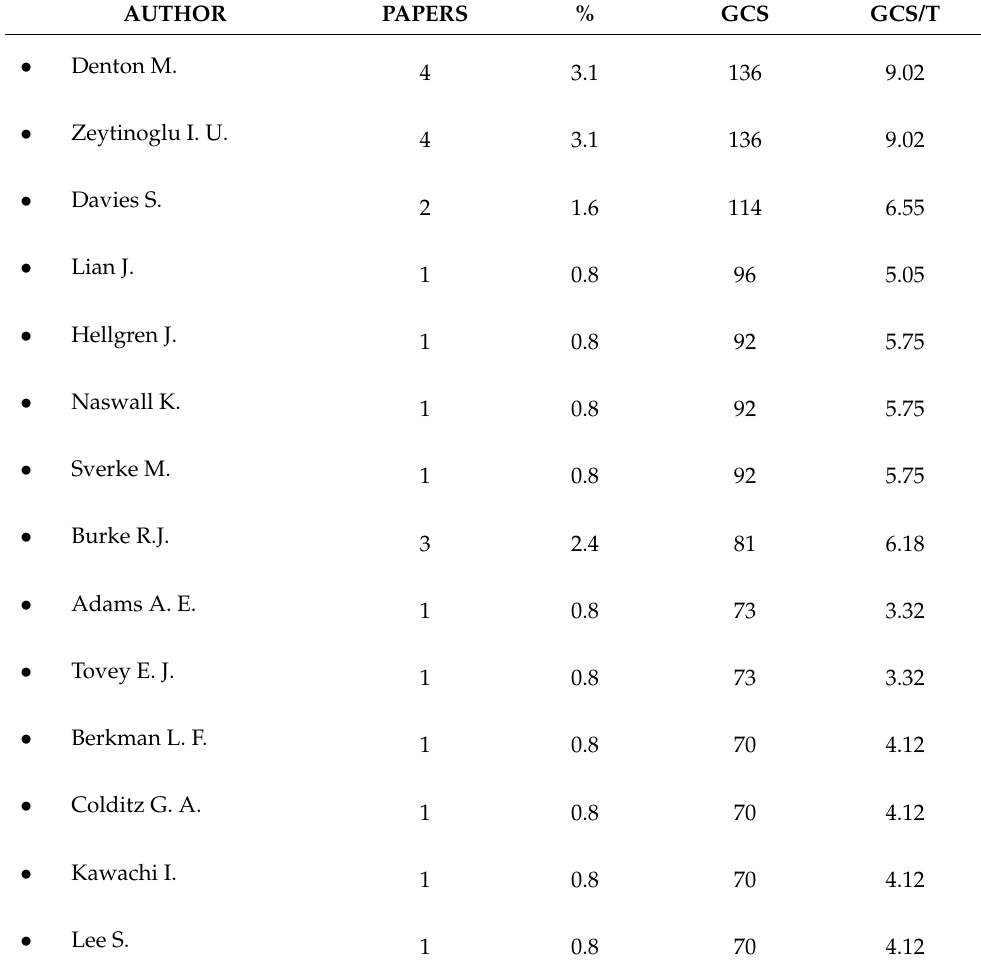
Table 1. Most cited authors (GCS ≥